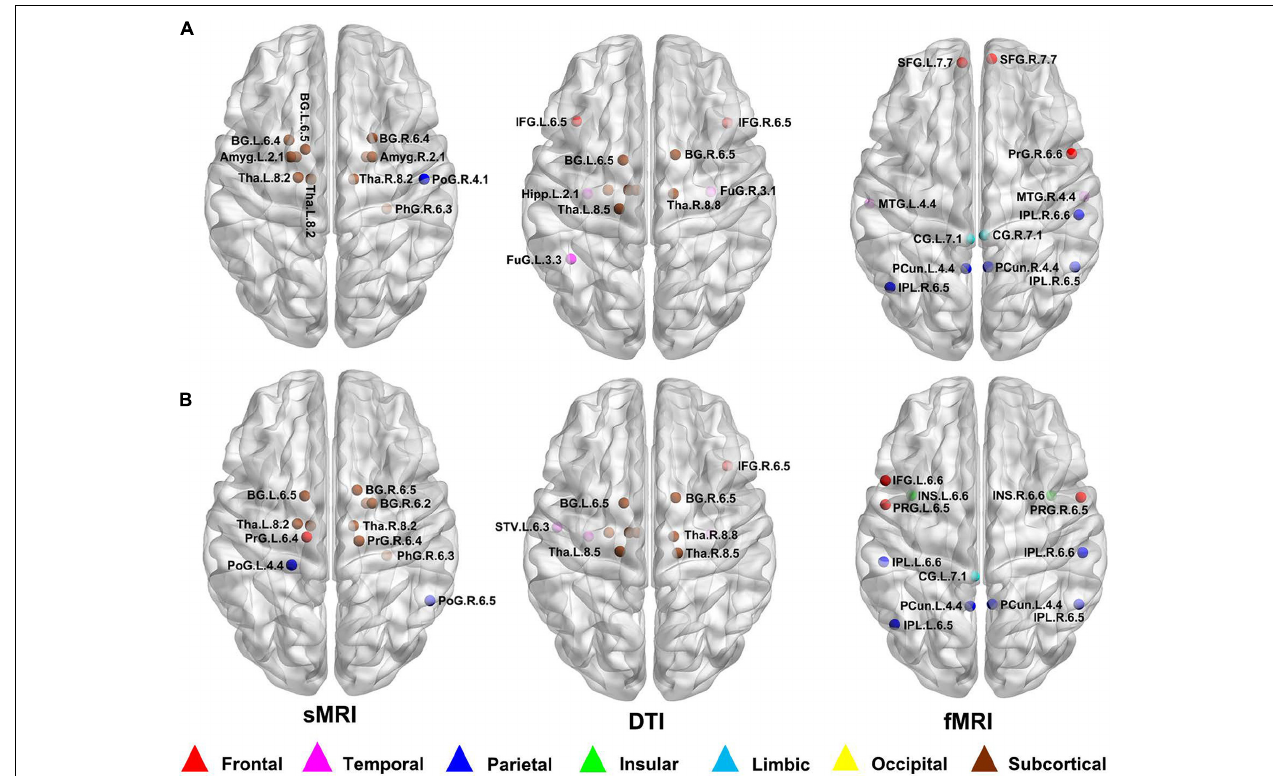
FIGURE 3 | Hub nodes of the SCD and HC groups in different brain networks. (A) Hub nodes of SCD in morphological, structural and functional brain network based on sMRI, DTI and fMRI; (B) Hub nodes of HC in morphological, structural and functional brain network based on sMRI, DTI and fMRI. The hub nodes were mapped on the ICBM 152 template with the BrainNet Viewer package (http://nitrc.org/projects/bnv/). sMRI, structural magnetic resonance imaging; DTI, diffusion tensor imaging; fMRI, functional magnetic resonance imaging; SCD, subjective cognitive decline; HC, healthy control.